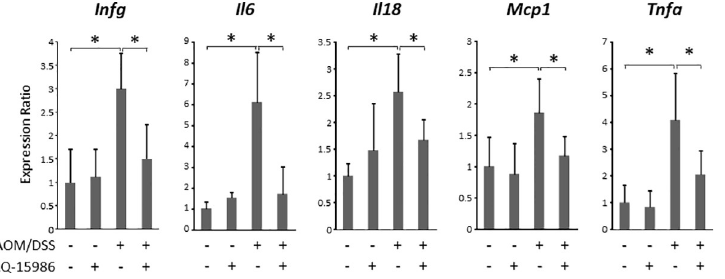
Fig 4. Effects of RQ15986 on the levels of pro-inflammatory cytokines in the colonic mucosa of experimental rats. Total RNA was isolated from colonic mucosa of the experimental rats, and expression levels of pro-inflammatory cytokine mRNA were determined using quantitative real-time RT-PCR with specific primers. Values are expressed as mean ± SD. Asterisk indicates statistically significant difference between the indicated groups; P < 0.05.